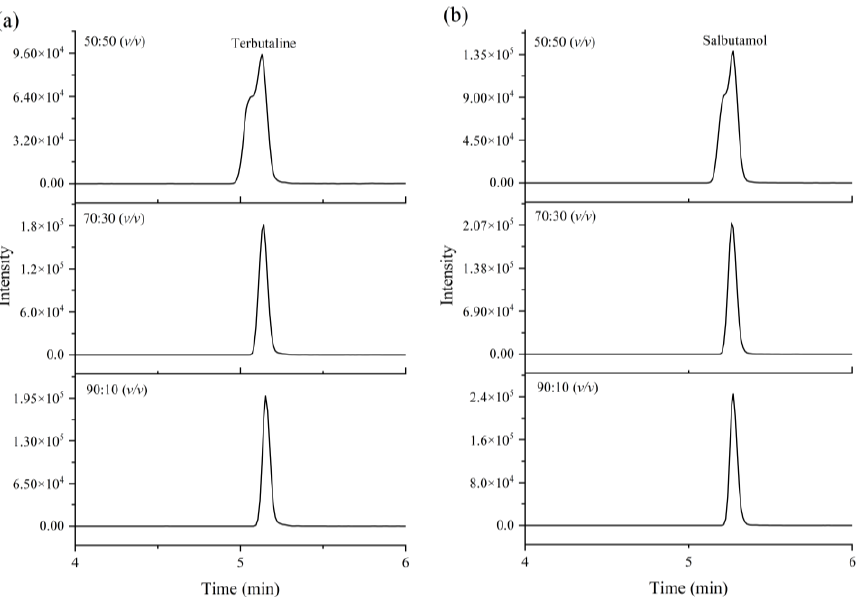
Figure 3. The solvent effect caused by methanol in redissolved solution. ( a ) Comparison of the peak shapes of Terbutaline in three redissolved solutions; ( b ) Comparison of the peak shapes of Salbutamol in three redissolved solutions.